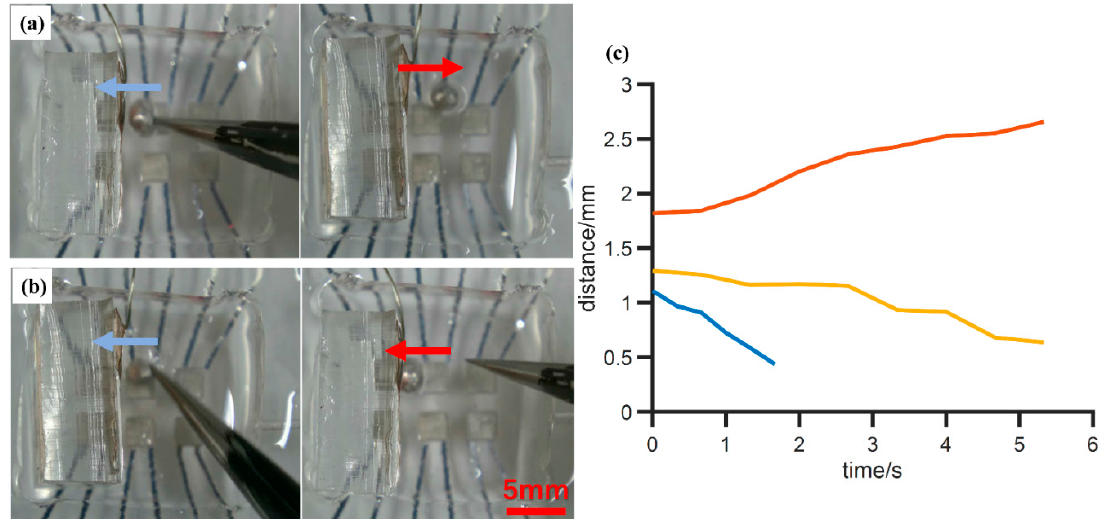
Figure 5. Experimental results of LM droplet moving towards a copper board electrode. Photo of droplet’s performance when it is further from ( a ) or nearer ( b ) the copper sheet electrode (+1000 V). ( c ) Test of droplet movement with different initial distance. Different colored lines represent different tests. x -axis: recording time; y -axis: distance between droplet center and board electrode. Zero time point is voltage application time.